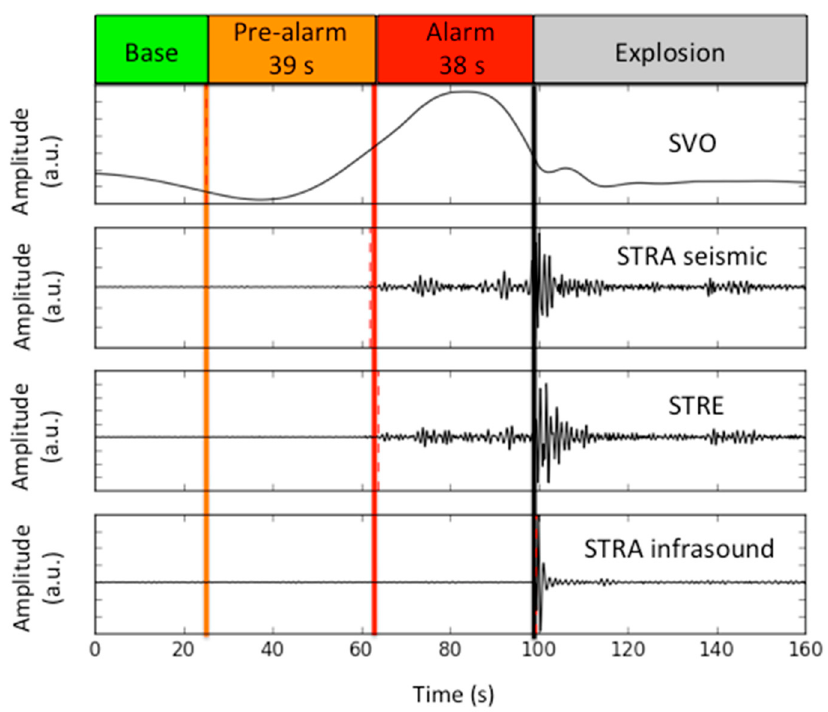
Figure 12. Outline of a proposal for a timely alarm system for the major explosions at Stromboli, based on strainmeter and seismic data. The vertical orange line marks the trigger of the Ultra Long Period signal, detected by the SVO borehole strainmeter 77 s before the potential impact of the explosion on the crater area, frequented by tourists. The red line marks the trigger of the seismic stations that recorded the precursory signal, about 38 s before the onset of the explosive phenomenon that is highlighted by the infrasound signal trigger (black line).